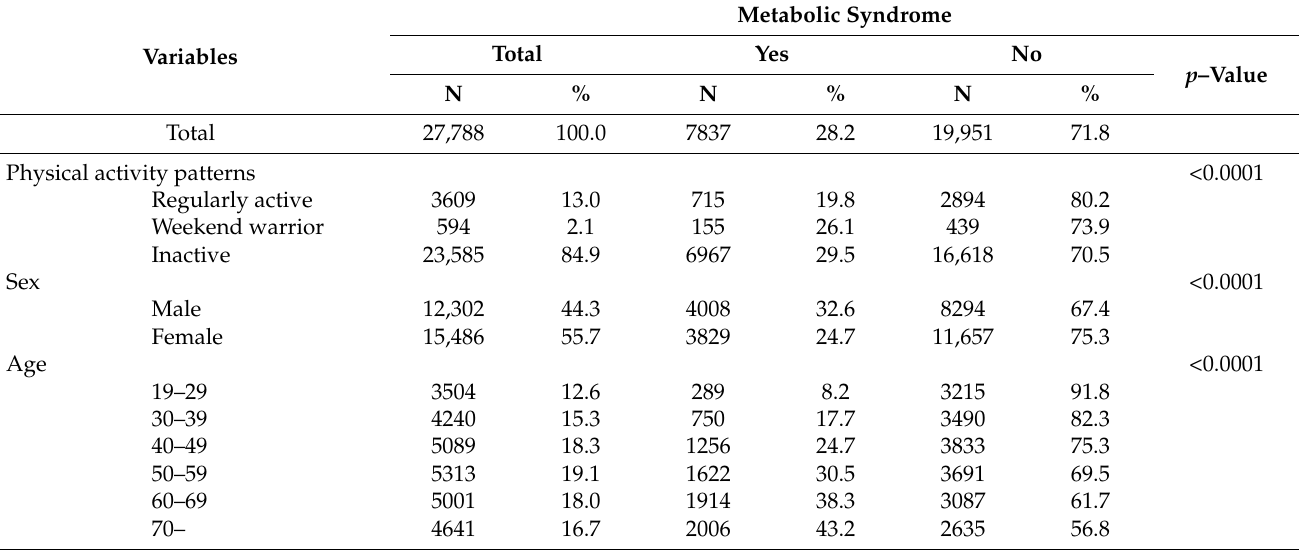
Table 1. General characteristics of the study